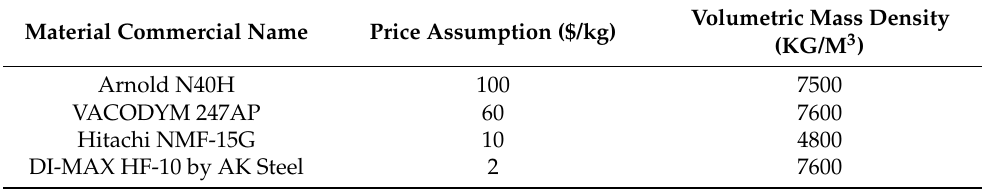
Table 4. Active material prices and volumetric mass density.